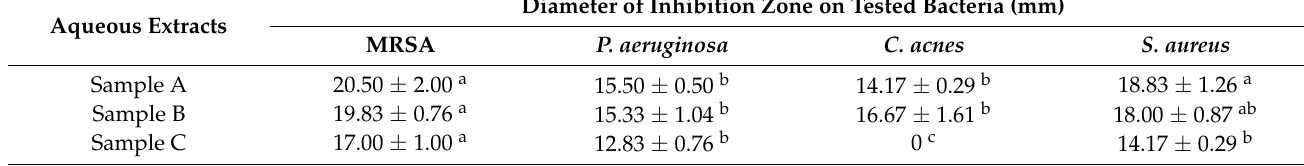
Table 5. Inhibitory effect of C. militaris extracts on skin pathogenic bacteria by agar well diffusion method.